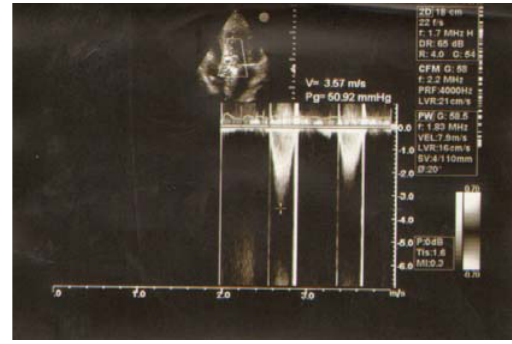
FIGURE 3. Postin fl ammatory moderate prostetic aortic valve